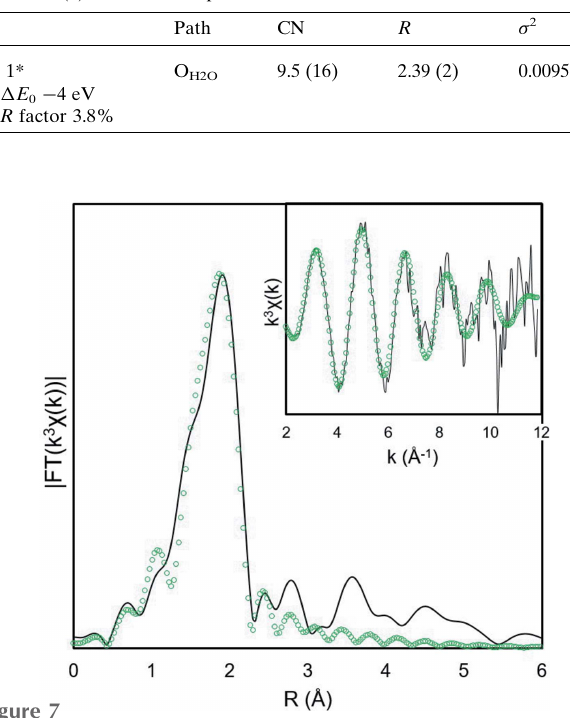
Figure 7 Experimental k 3 -weighted EXAFS oscillations (line) and best fits (open circles) obtained after 30 min electrolysis at (cid:2) 250 mV